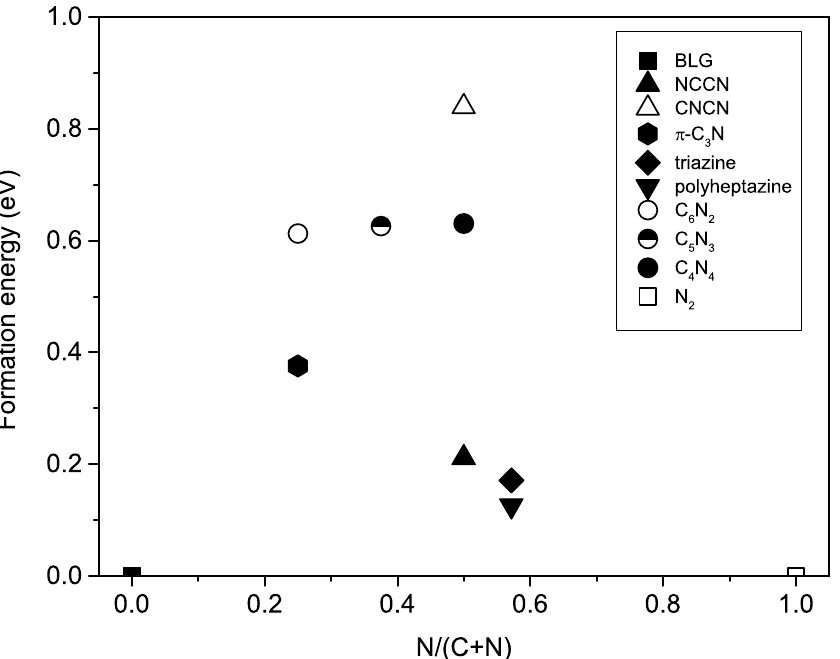
Figure 4. Formation energy of two-dimensional (2D) carbon nitrides is plotted with respect to the N concentration in the structures, where pure C phase is graphene and pure N phase is N 2 molecule. The formation energies of NCCN, CNCN, π -C 3 N, triazine, and polyheptazine phases are from Ref.